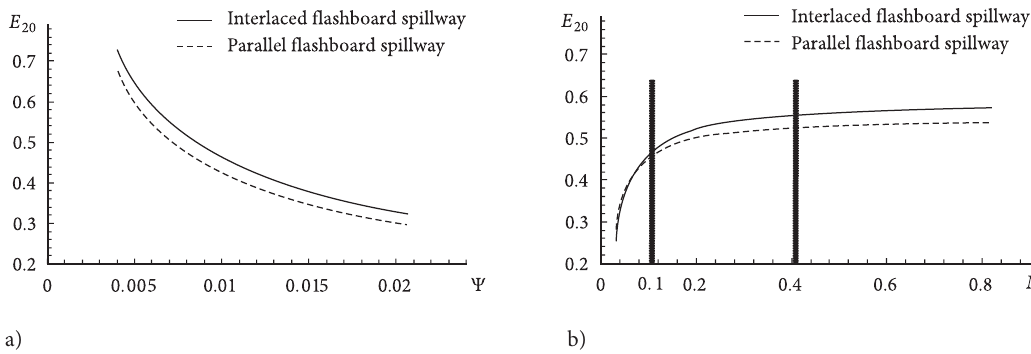
of flashboard spillways as a function of: (a) Ψ for a particular N * ; (b) N * for a particular Fig. 11. E 20